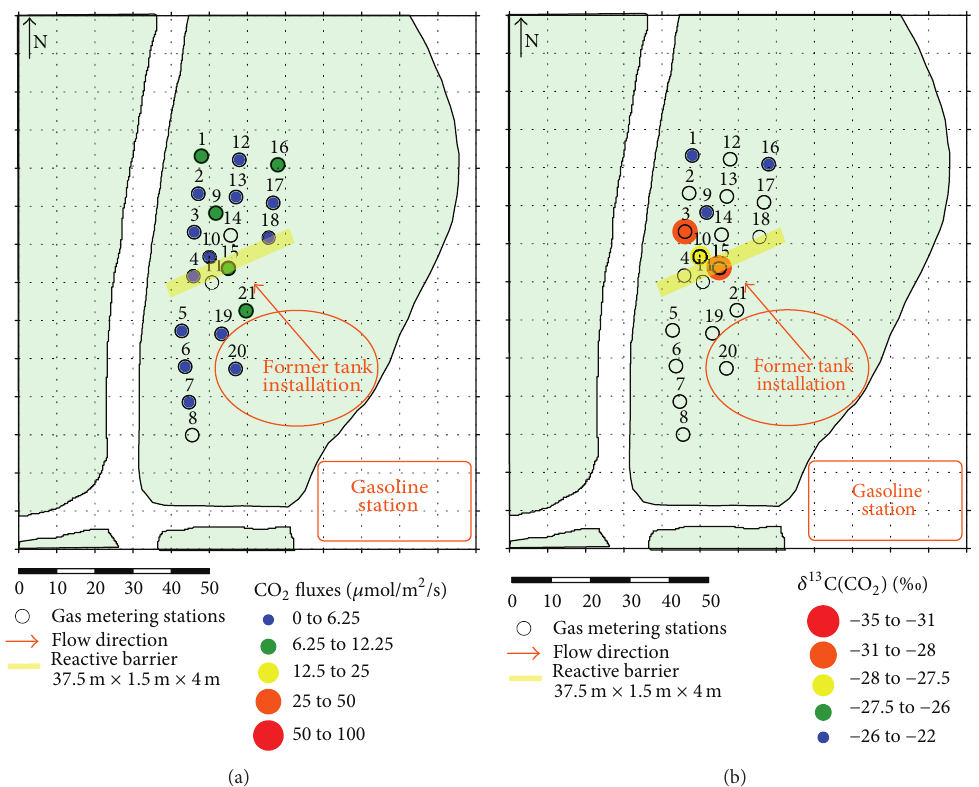
Figure 5: Maps of measured CO 2 emissions (a) and its carbon isotopic ratio versus VPDB (b), in February 2014.